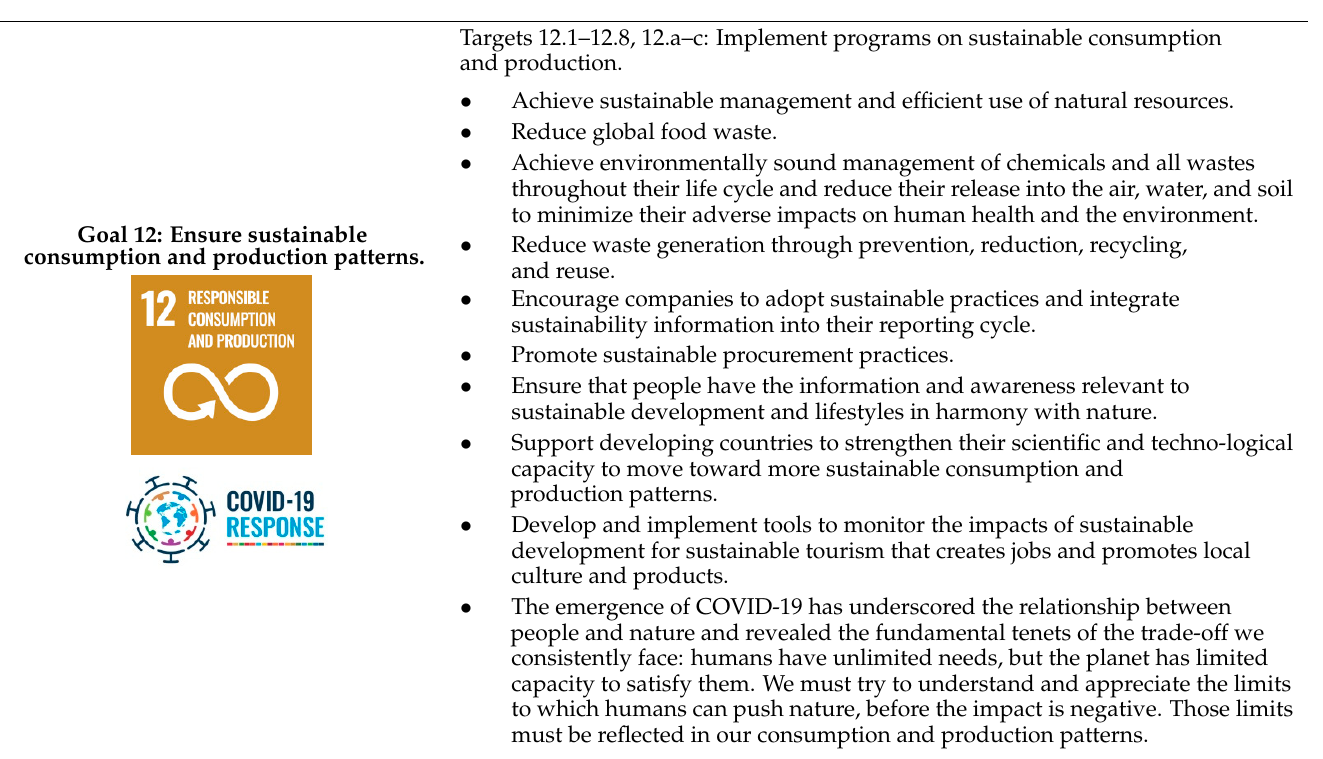
Table 5. Impact of the Sustainable Development Goals on IoT applications for improving health and the environment. SDGs Targets Goals and Application to IoT